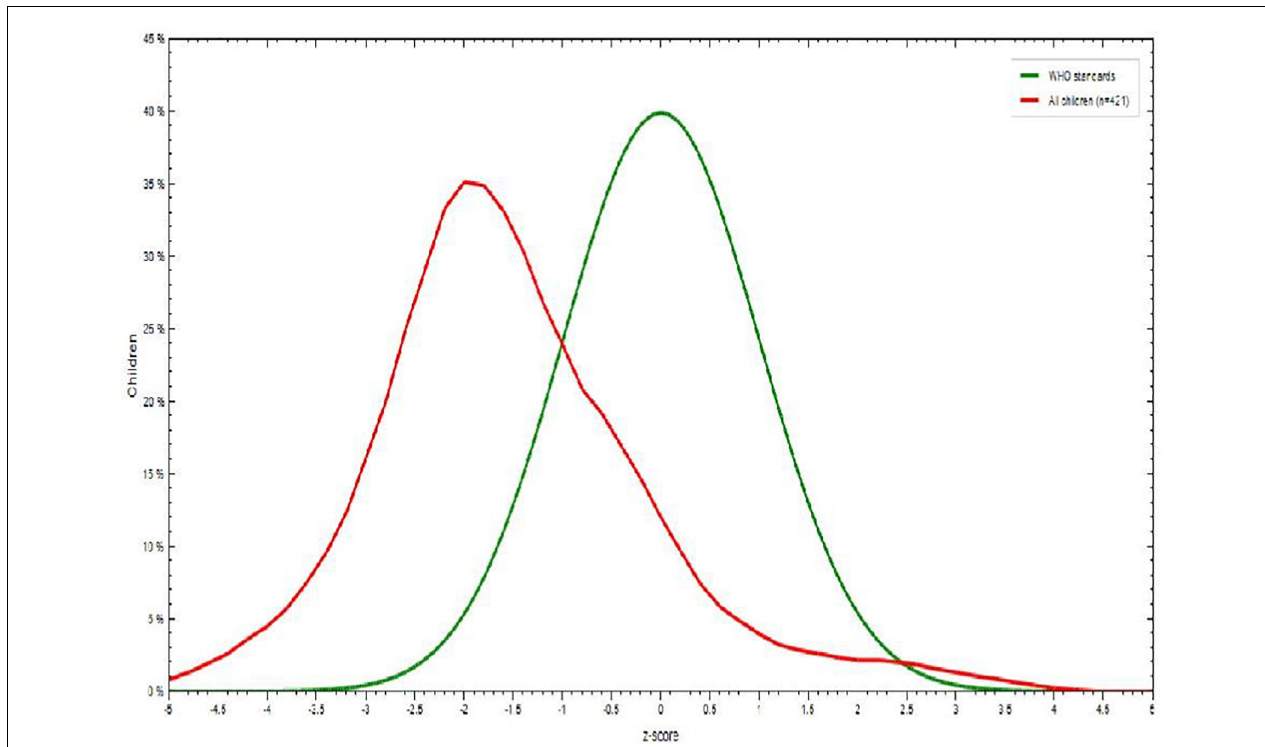
FIGURE 1 | Height-for-age Z score among children aged 6–23 months in Dessie town, Northeastern Ethiopia, 2021.